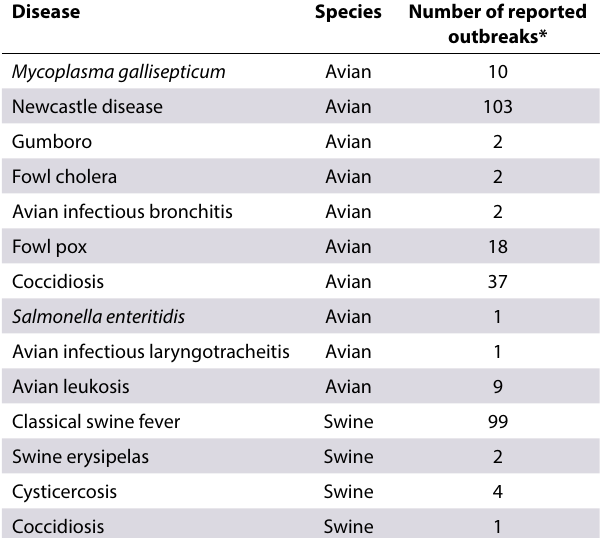
Table III: List of pig and poultry diseases found in the Eastern Cape Province in the national database (DALRRD) from 1999 to 2019 Disease